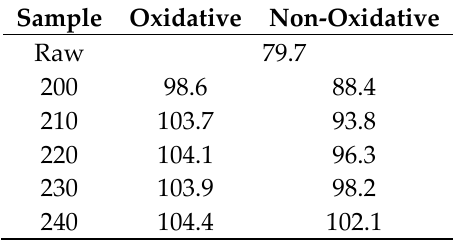
Table 2. Contact angle measurements for SRCP